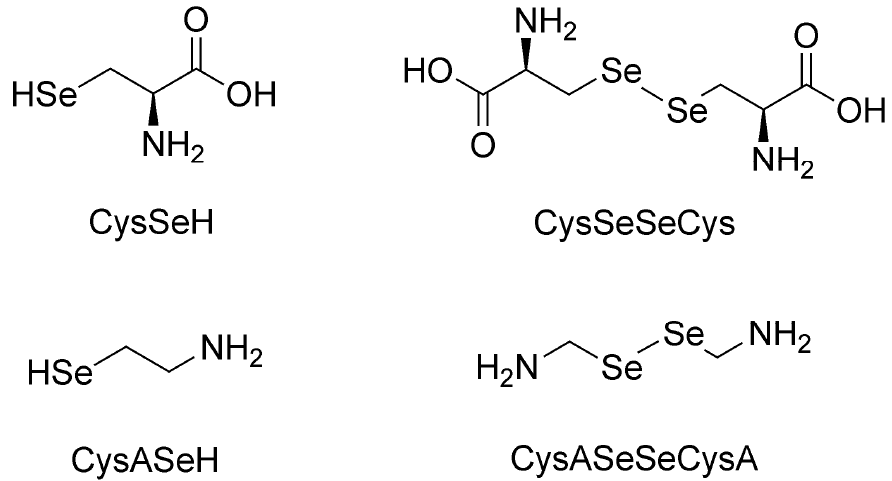
Figure 1. The structure of the investigated selenols (left) and diselenides (right).